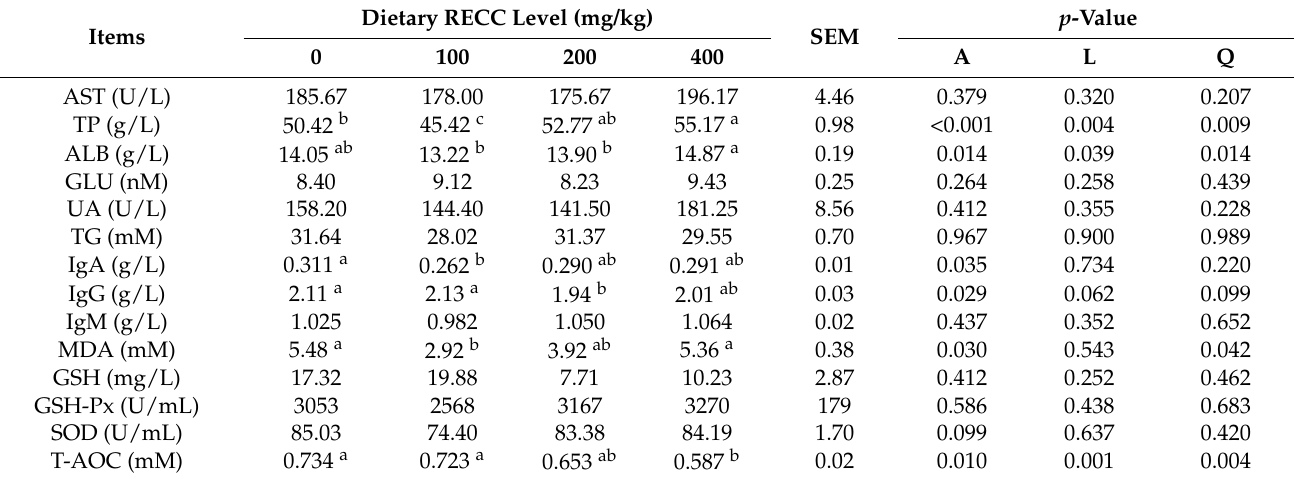
Table 4. Effects of dietary rare earth chitosan chelates (RECC) on serum indexes of laying